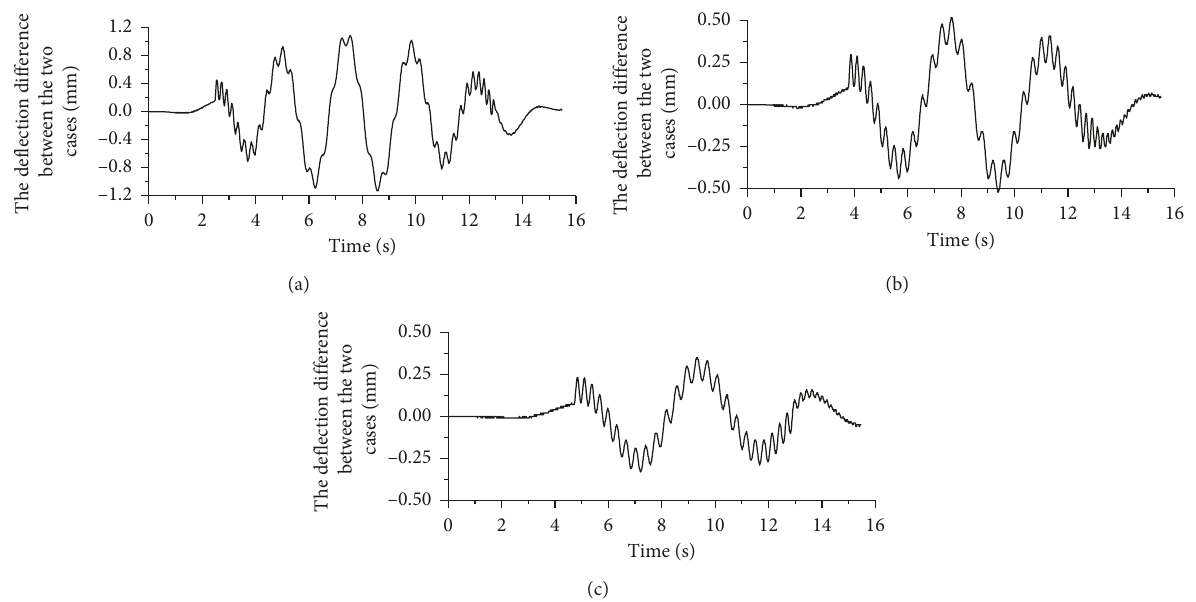
Figure 8: The difference between the two models: (a) when the cable length is 6m; (b) when the cable length is 14 m; (c) when the cable length is